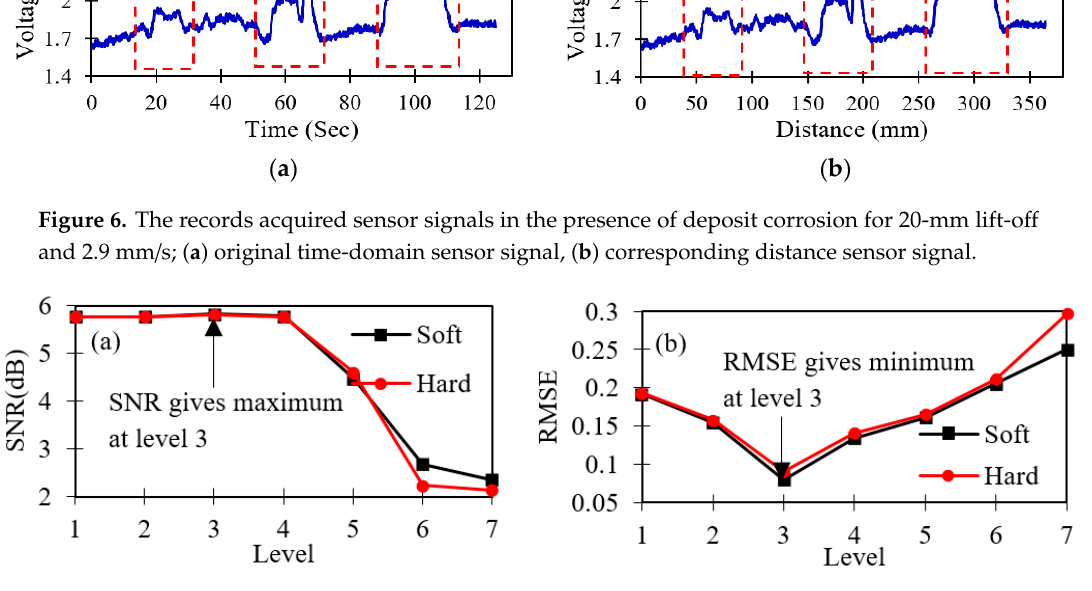
Table 3. Effect of decomposition level and de-noising on the SNR and RMSE of the sensor signal.